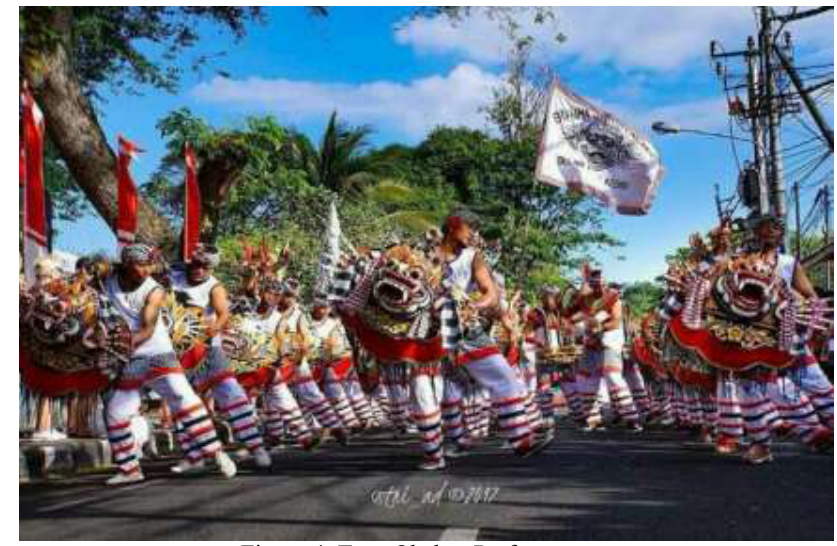
Figure 4. Two Okokan